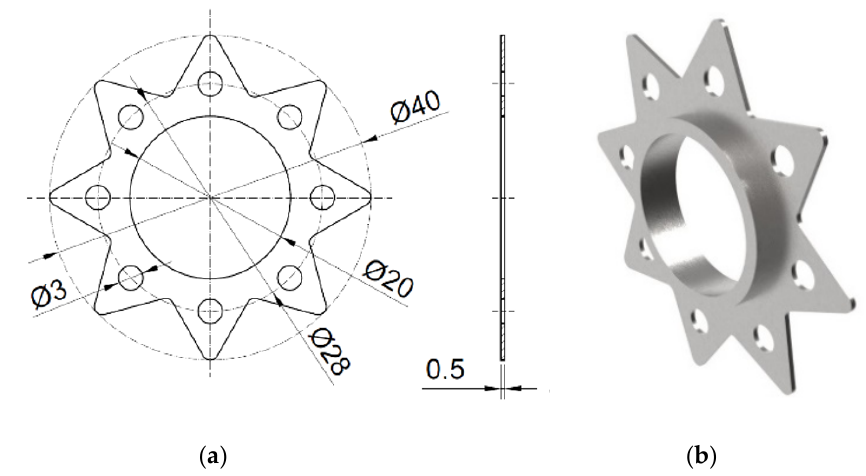
Figure 1. The geometry of the perforated star-shaped fin ( a ), and 3D model ( b ).